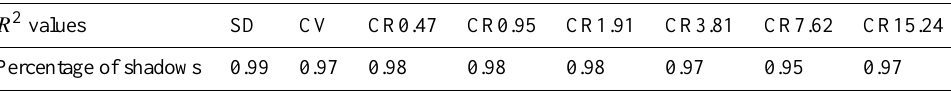
Table 3. R 2 values of indexes for sandy clay loam soil. Results obtained from regressions between percentage of shadows and the micro relief statistical indexes, CV and SD, and a single chain set, expressed as chain roughness (CR). R 2